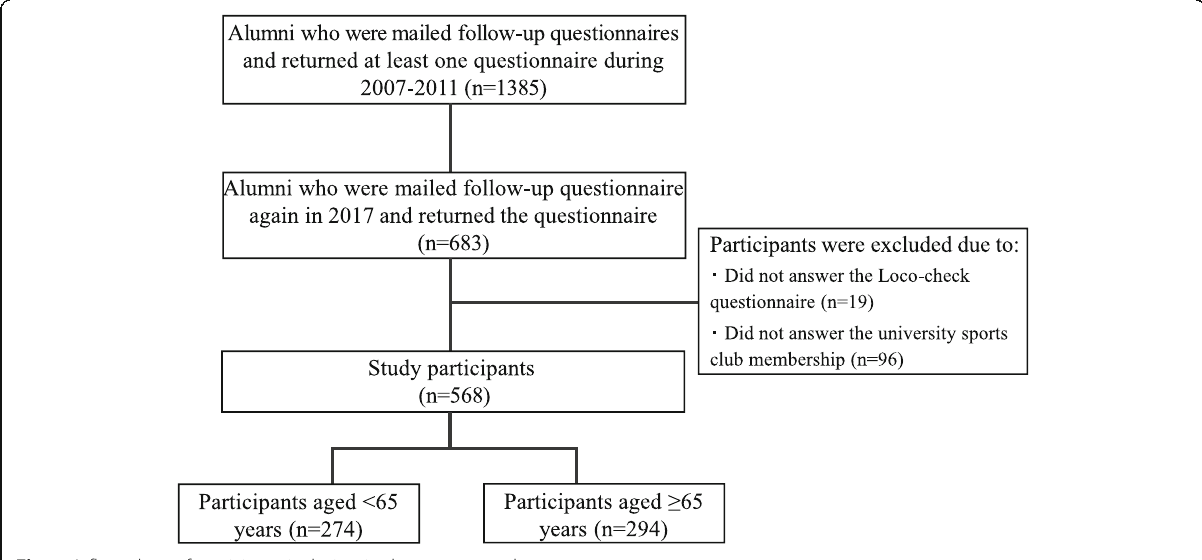
Fig. 1 A flow-chart of participant inclusion in the present